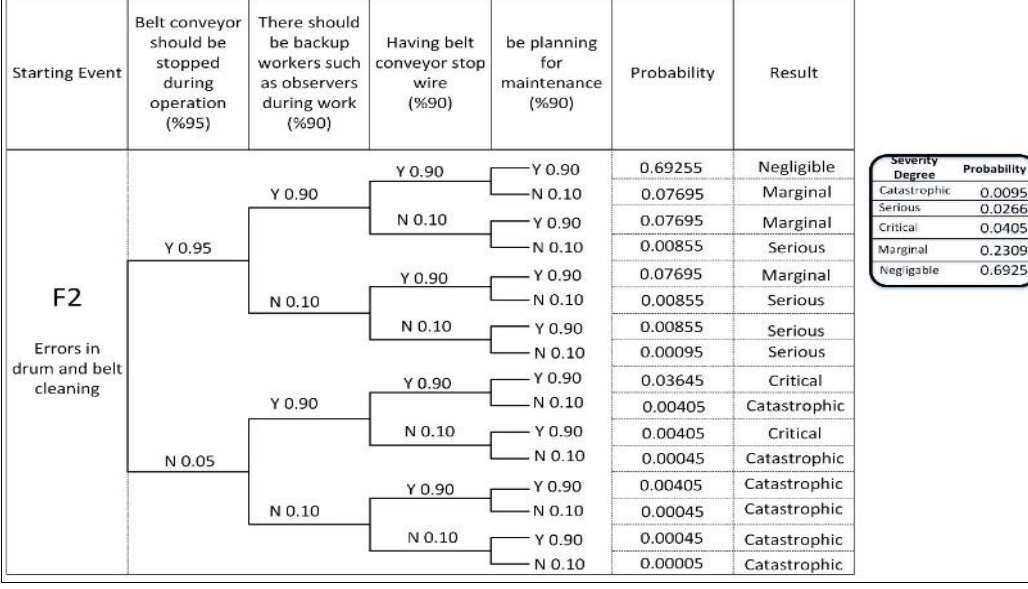
Figure 6: Event tree analysis diagram of